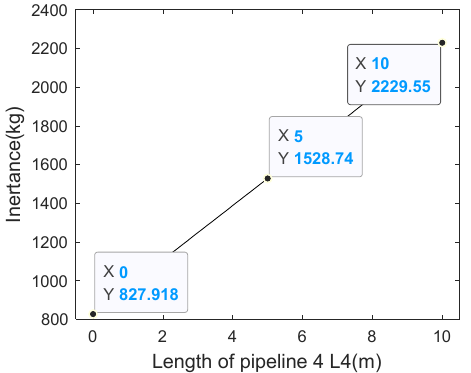
Figure 6. The relationship between inertance and L 4 . In the single-cylinder fluid inerter, as the secondary flow on the section of the pipe increases the damping force when the fluid flows in the spiral pipe, the inertia force is relatively small [16]. When sinusoidal speed signals shown in Table 2 are used, the change curves of inertia and damping forces over time are shown in Figure 7.